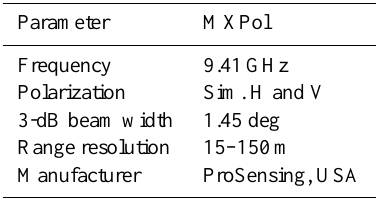
Fig. 3. Successive sun-tracking windows for Position 1, collected on July 14 2010. Table 3. Principal technical parameters of the MXPol radar.